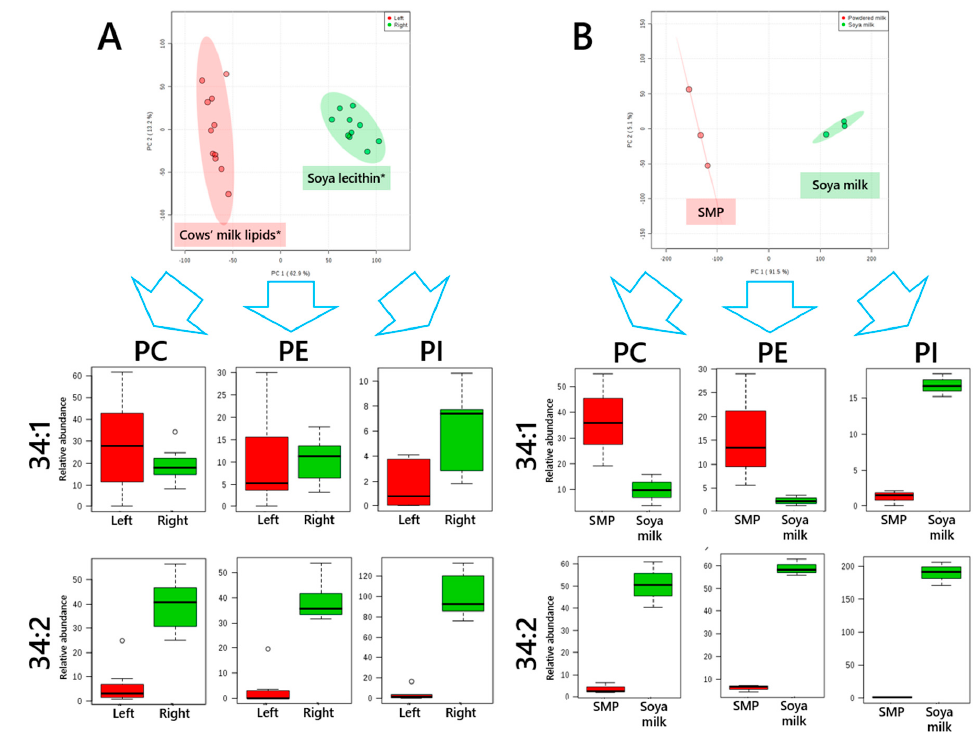
Figure 2. Principal Component Analyses and important loading variables of the phospholipid composition of formula UKB1 and reference materials. Panel ( A ), British brand 1 (UKB1) with subgroups that represent the hypothesised (*) dominant lipid source hypothesised marked (Red, cows’ milk lipids; Green, soya lecithin). ( B ), Plot of lipids from skimmed milk powder (SMP) and soya milk with loadings indicating which variables are the most important for distinguishing the two sample types. PC, phosphatidylcholine; PE, phosphatidylethanolamine; PI, phosphatidylinositol. R 2 values for each component are shown in parentheses on each axis.